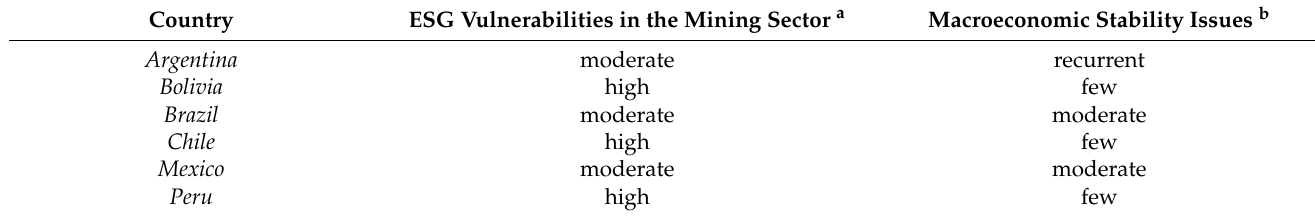
Table 4. Potential Member National Characteristics